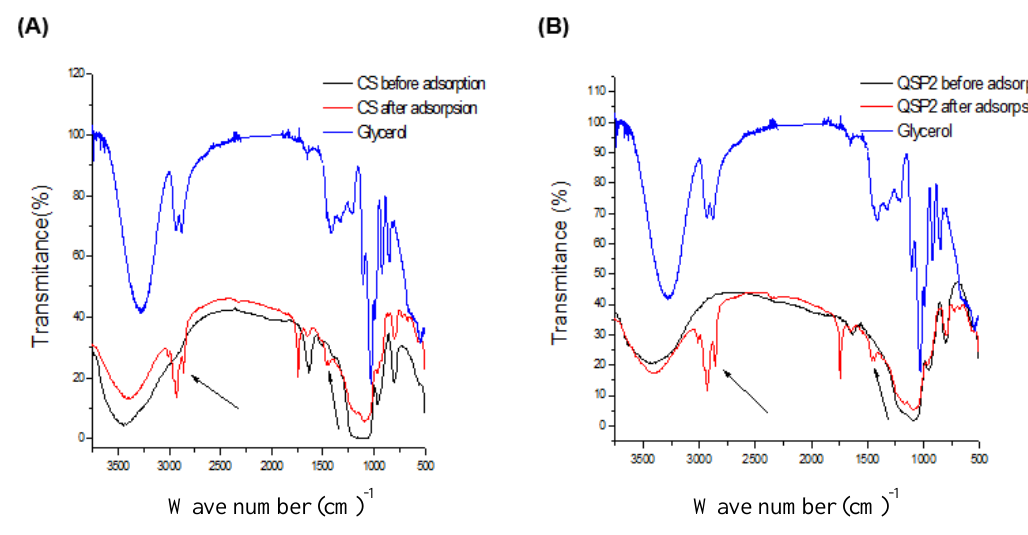
Figure 7. FTIR spectra of CS ( A ) and CSP ( B ) before and after